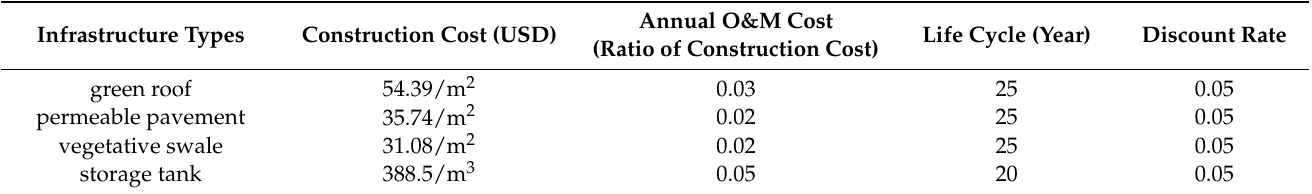
Table 2. The cost information of green and gray infrastructure in the study